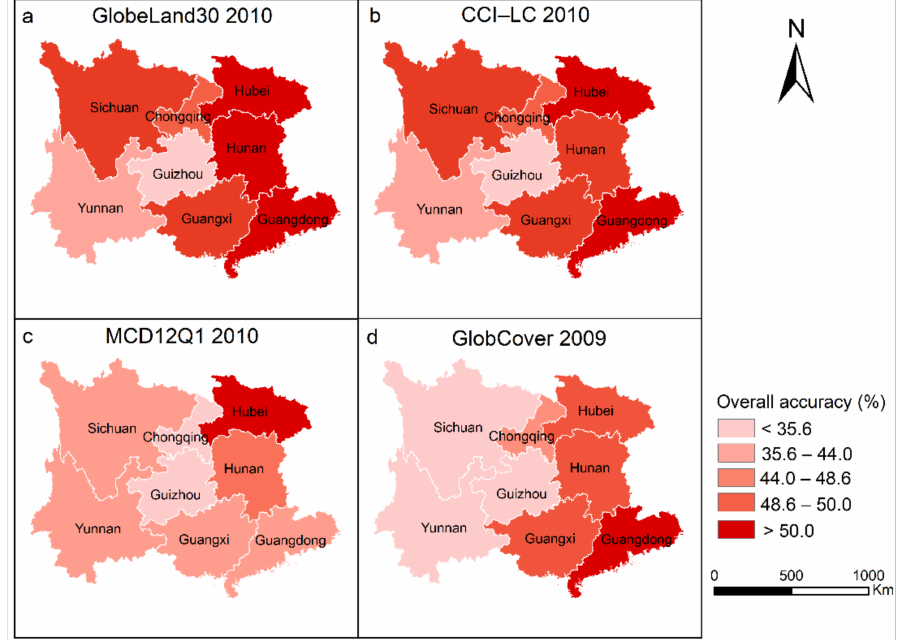
Figure 6. Distribution maps of the overall accuracy of global LC datasets at the provincial scale in southern China in epoch